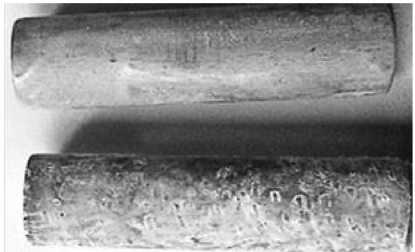
Figure 7: Appearance of corroding aluminum parts of